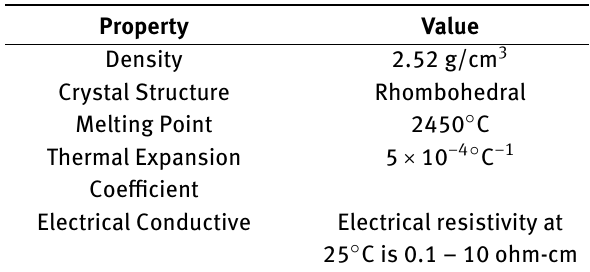
Table 2: Measured properties of AA2024 alloy